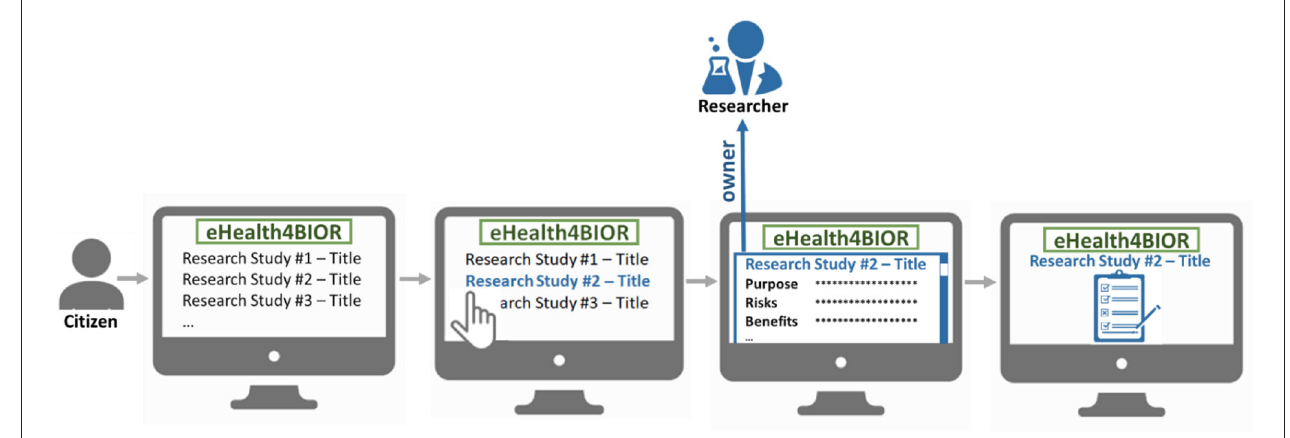
FIGURE 2 | The process of the voluntary participation of a citizen to a research study under the eHealthBioR